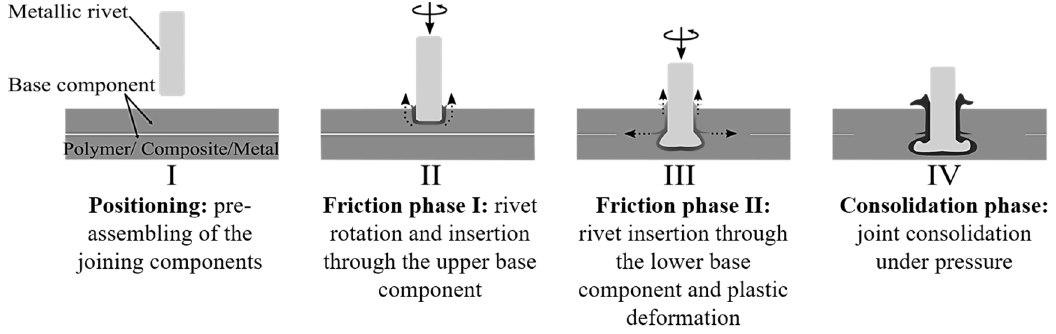
Figure 1. Schematic description of the Direct-FricRiveting process.